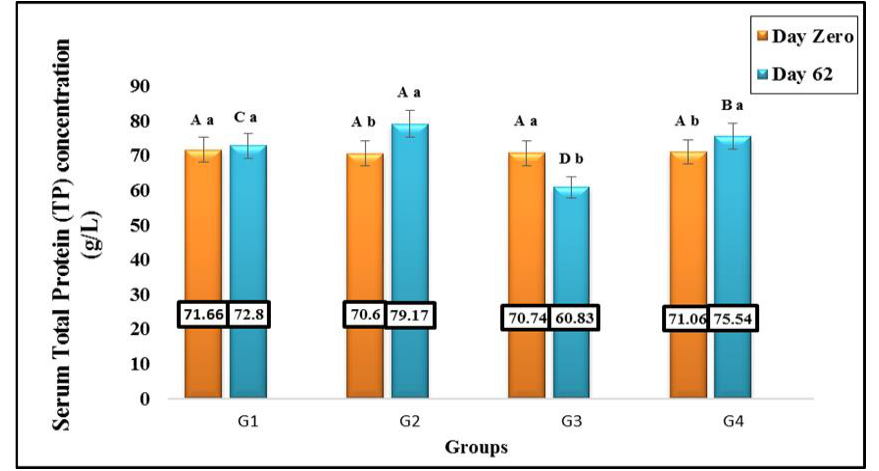
Figure 8. Effect of phosphatidylcholine, fructose and/or combination on serum total protein (TP) concentration (g/L). Mean ± SE, n = 9 in a group. G1 control groups (C), G2: (Pc), G3: (Fr), G4: (Fr + Pc). A-C Significant variations P ≤0.05 between